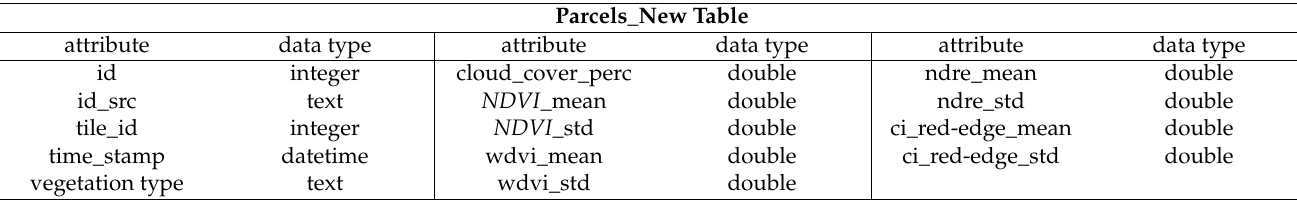
Table 2. Most important field names including data types of the parcels_new table containing calculations on vegetation index time series derived from Sentinel-2 data that are uploaded to the Nexus